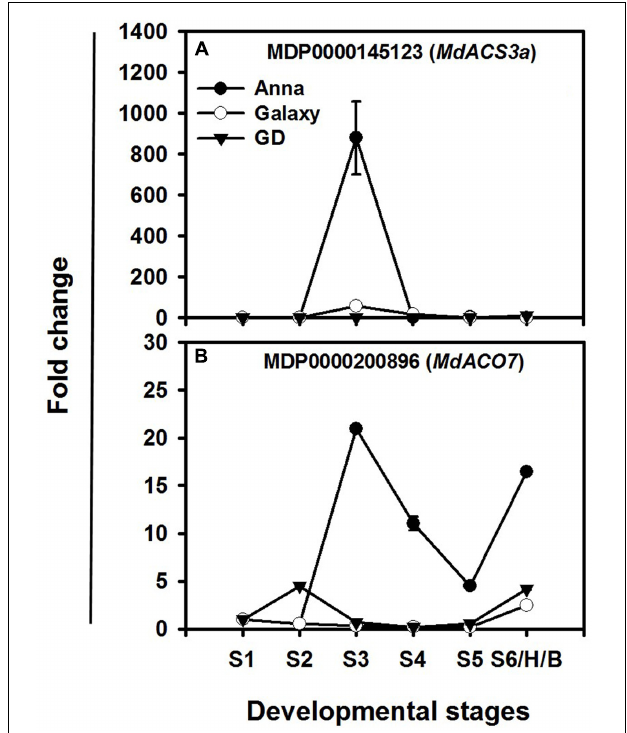
FIGURE 7 | Expression profiles of (A) MdACS3a and (B) MdACO7 genes during different stages of fruit development (S1–S6/H/B). Expression of genes at each stage was calculated by 2 − (cid:49)(cid:49) C t method, considering to the expression obtained at S1 stage and to HKG (actin) and is presented as relative fold change. Each value is the mean of three technical replicates ± SE. This is a representative of two independent